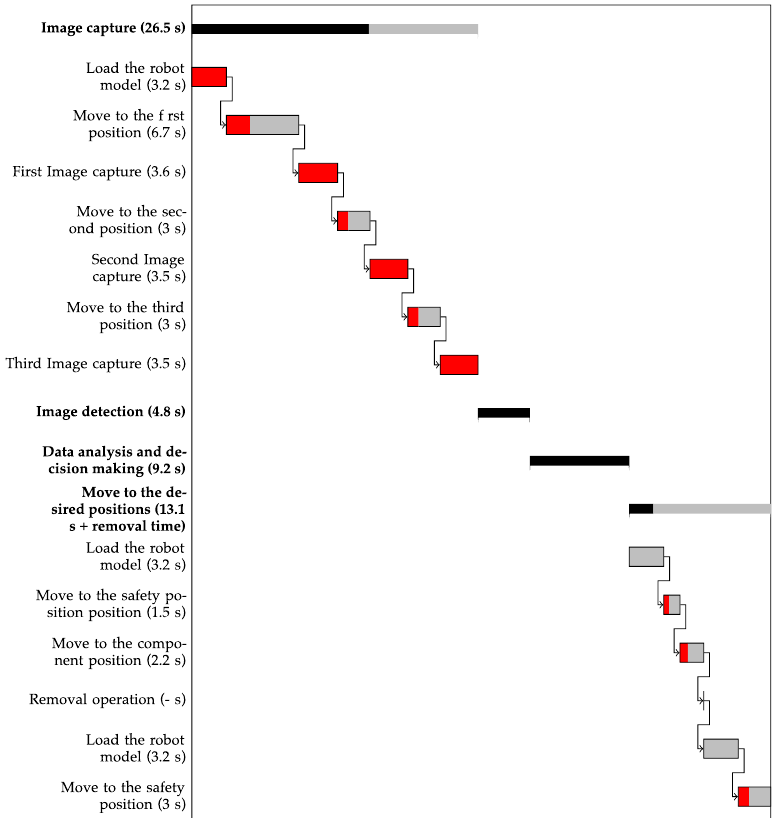
Figure 10. Timing summary at 25% speed in grey and expected timing at full speed in black and red. 249